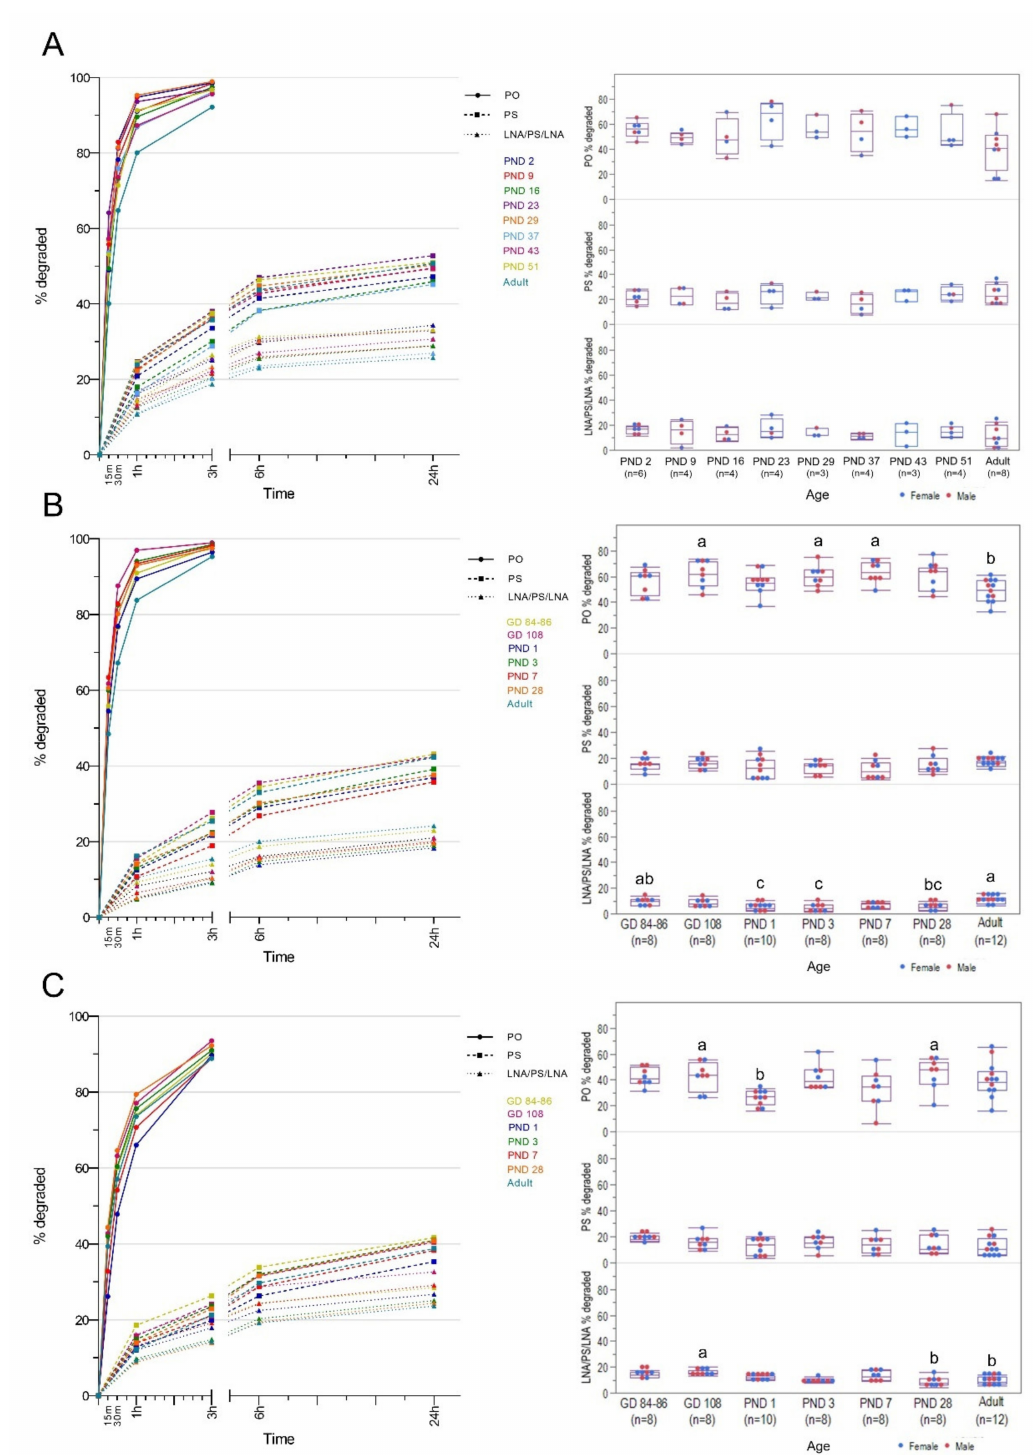
Figure 9. Degradation of isosequential ASOs: unmodified (PO), all-PS (PS), and LNA/PS/LNA gapmer (RTR5001) in ( A ) plasma, ( B ) kidney, and ( C ) liver over time in the developing and adult Göttingen Minipig. Nuclease activity is represented by the percentage of degraded ASO fraction for each incubation time on the left panel: PO (0, 115, 30, 60, 180 min), PS and LNA/PS/LNA (0, 1, 3, 6, 24 h). The rate of ASO degradation for the two modified sequences slowed down between 6 and 24h of incubation. The degraded ASO fraction percentages at the 15 min (PO) and 1 h (PS, LNA/PS/LNA) time points between different age groups are presented in the right panels. Age groups not sharing the same letter are significantly different ( p <